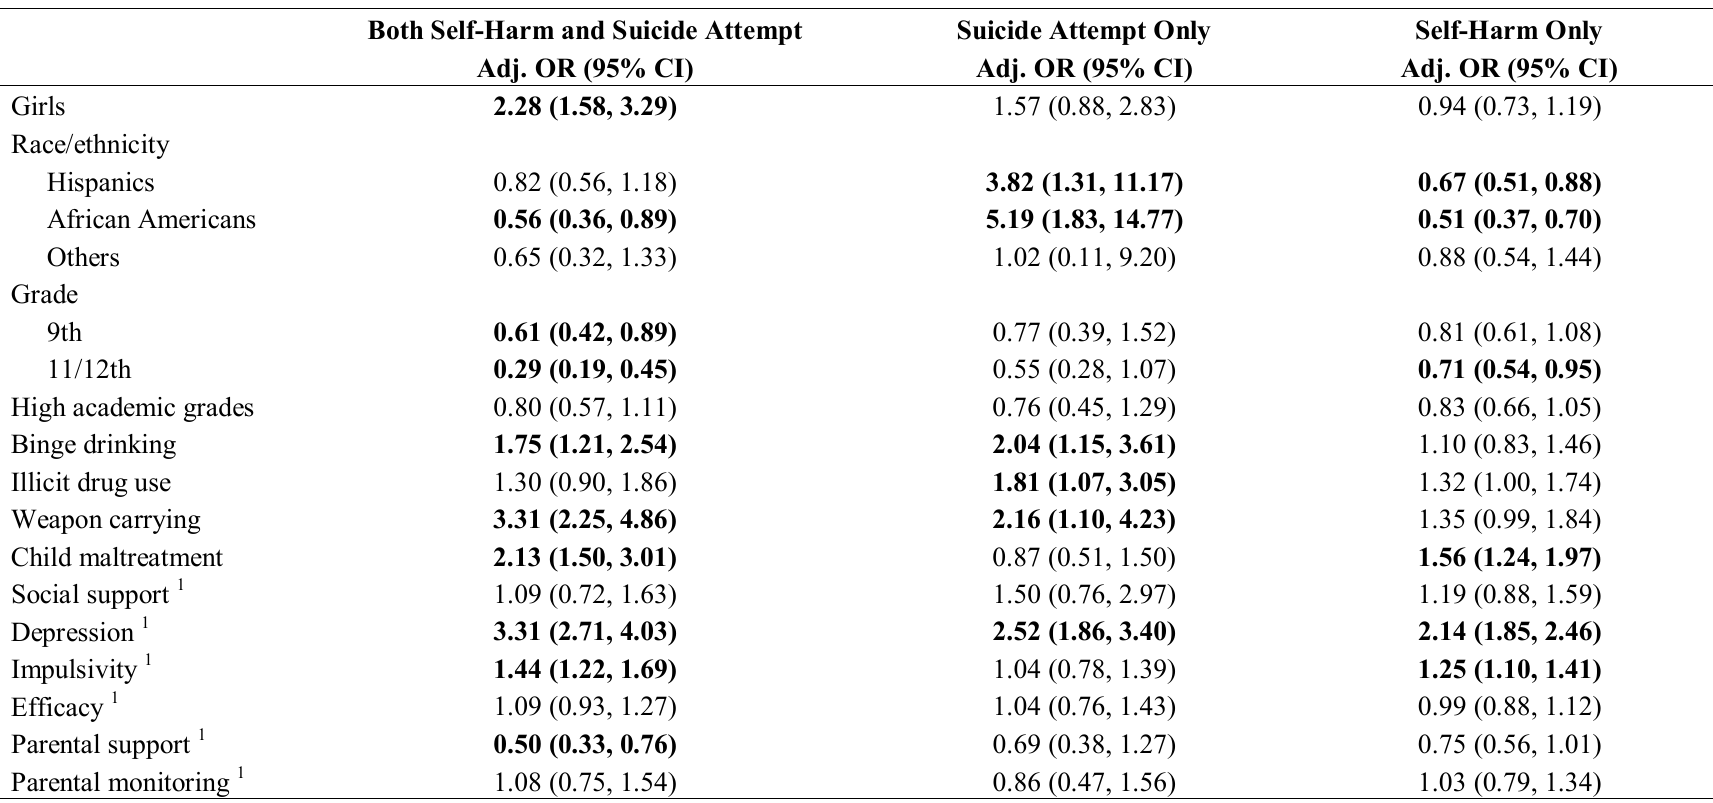
Table 2. Multivariate associations between demographic and psychosocial characteristics and self-harm and suicide attempts among high-risk urban youth in the